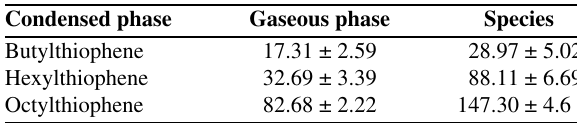
Table 3. Experimental values for standard molar enthalpies of for- mation (kJ mol –1 ) for thiophene derivatives at 298 K. 44